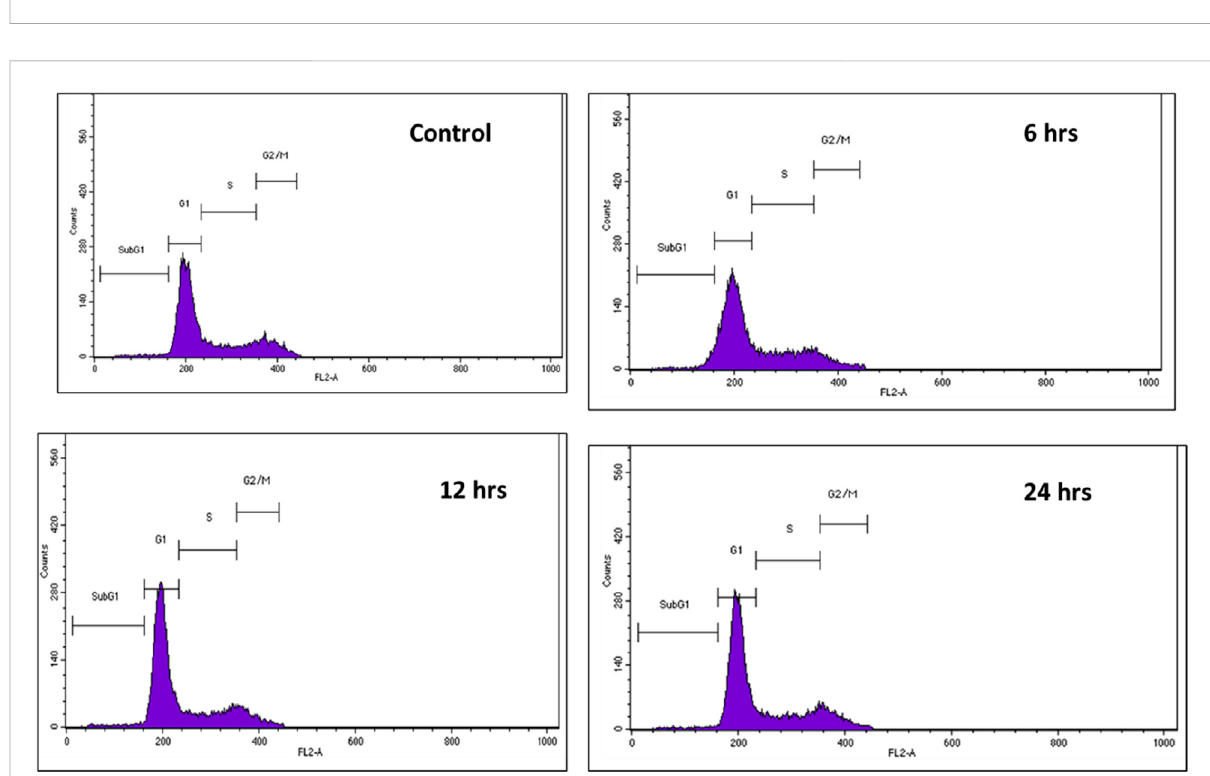
FIGURE 11 Effect of Silibinin and Sb-GNPs on cell cycle arrest in lung cancer